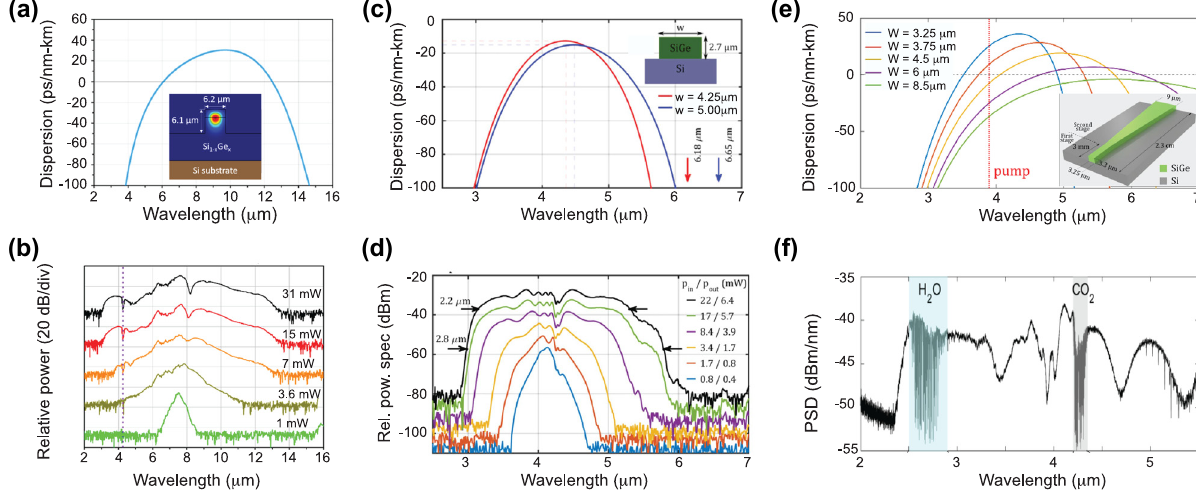
Figure 12: SCG in Ge based platforms. (a) Simulated dispersion in a graded index SiGe/Si waveguide, inset: waveguide schematic with mode profile at 7.5 μ m. (b) SCG for different pump powers. (c) Simulated dispersion in a step index SiGe/Si waveguide, inset: SEM image. (d) SCG for different pump powers showing ANDi regime. (e) Simulated dispersion in a two-stage SiGe/Si waveguide, inset: waveguide schematic. (f) SCG in the two-stage SiGe/Si are highlighted by the shaded areas. Panels (a) and (b) adapted from [59]. Panels (c) and waveguide. The absorption dips from water vapor and CO 2 (d) adapted from [15]. Panels (e) and (f) adapted from